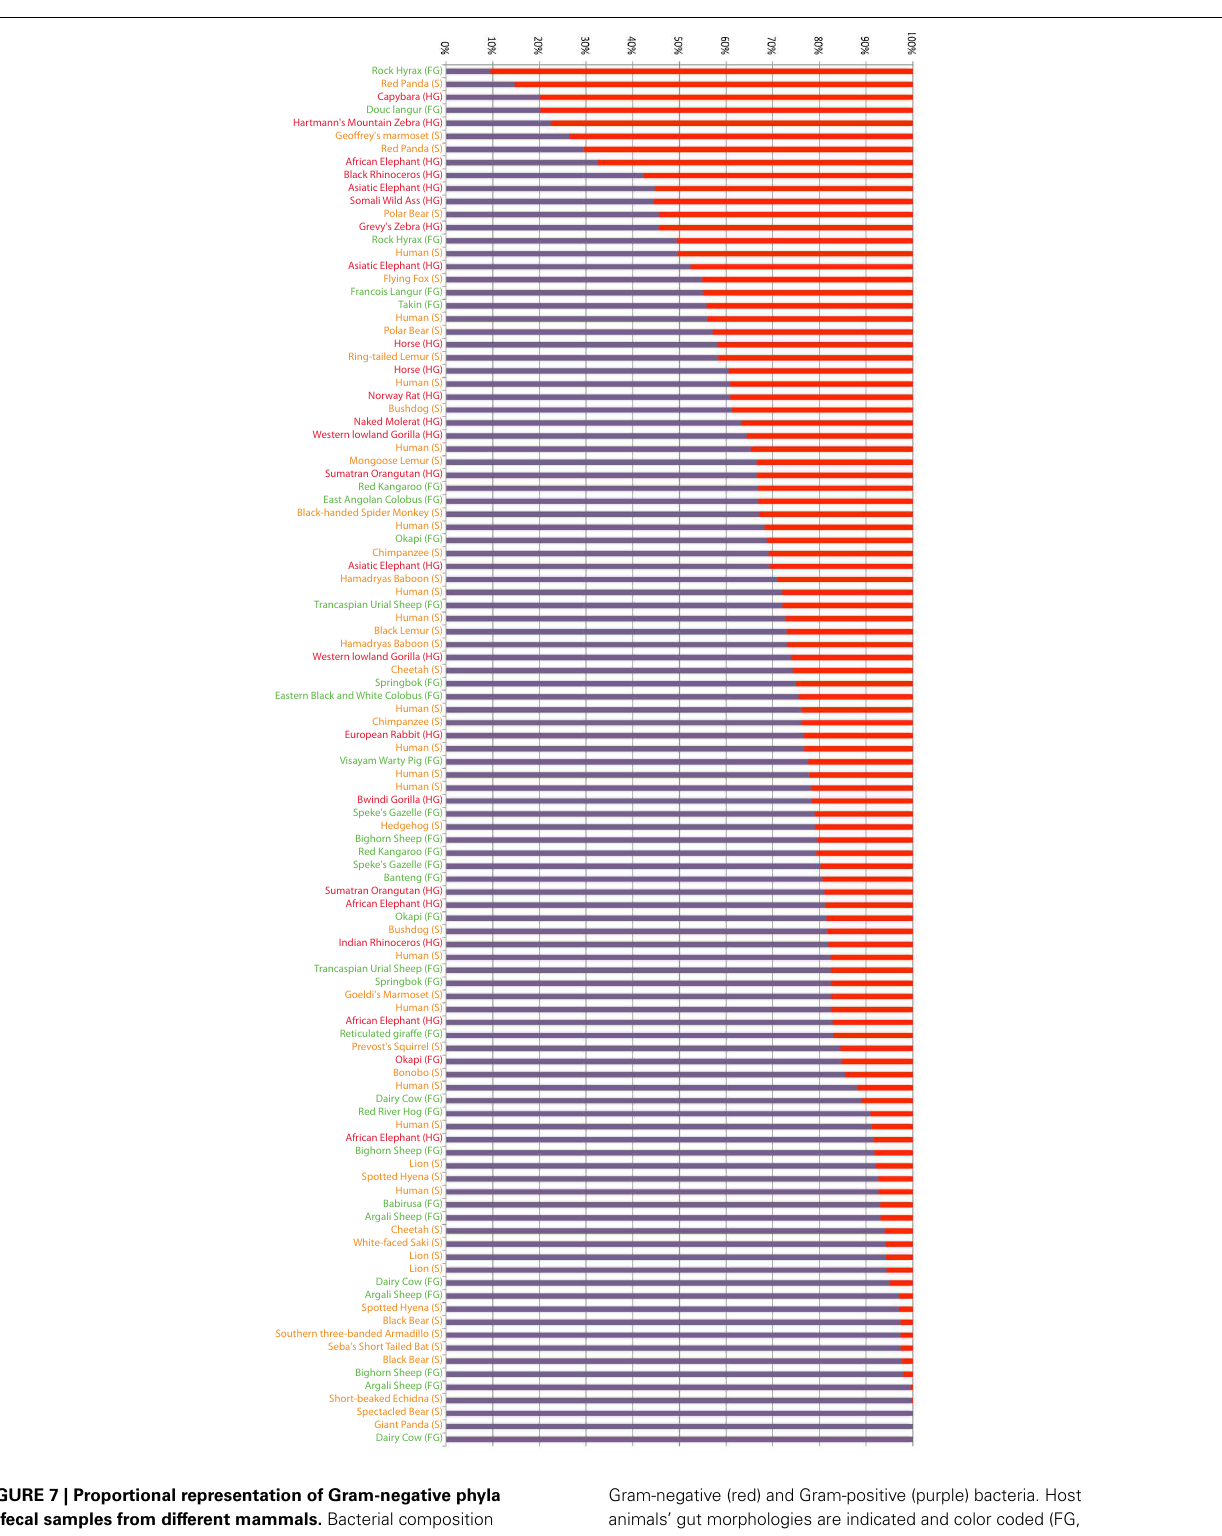
FIGURE 7 | Proportional representation of Gram-negative phyla in fecal samples from different mammals. Bacterial composition of mammalian fecal samples, as previously reported (Ley et al., 2008a), are represented as the proportion of phyla composed of